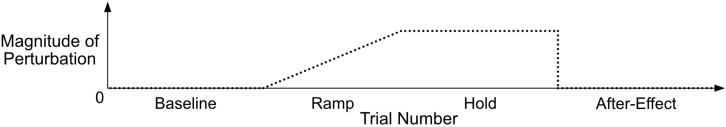
A schematic of a typical sensorimotor adaptation paradigm with four phases. During the baseline phase, participants receive normal auditory feedback (magnitude of perturbation = 0). The perturbation is gradually increased from 0 to its maximum value during the ramp phase. The maximum perturbation is held constant during the hold phase. Auditory feedback immediately returns to normal during the after-effect phase.